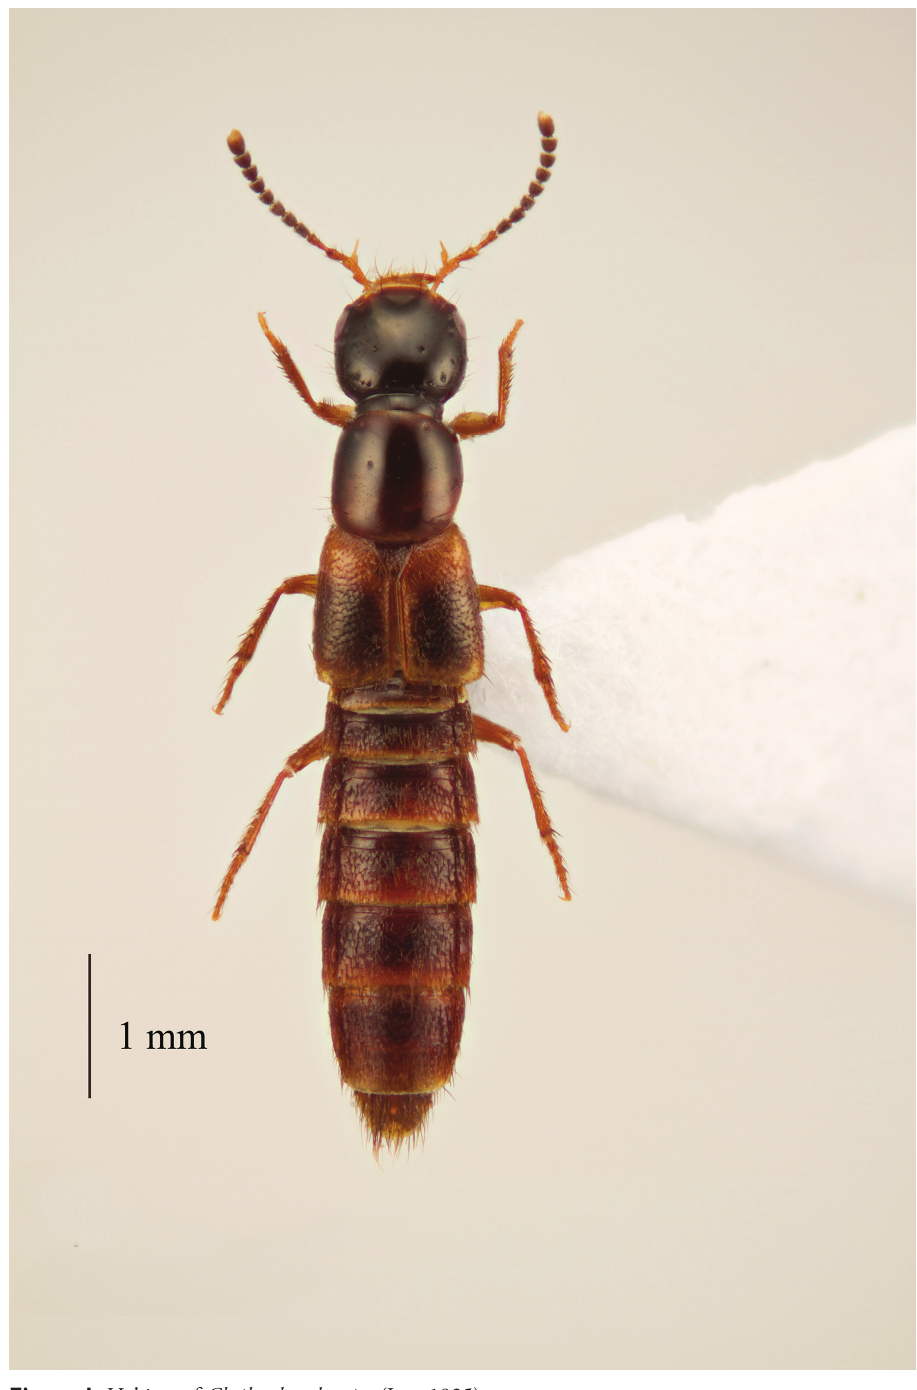
Figure 1. Habitus of Cheilocolpus kentiae (Lea,